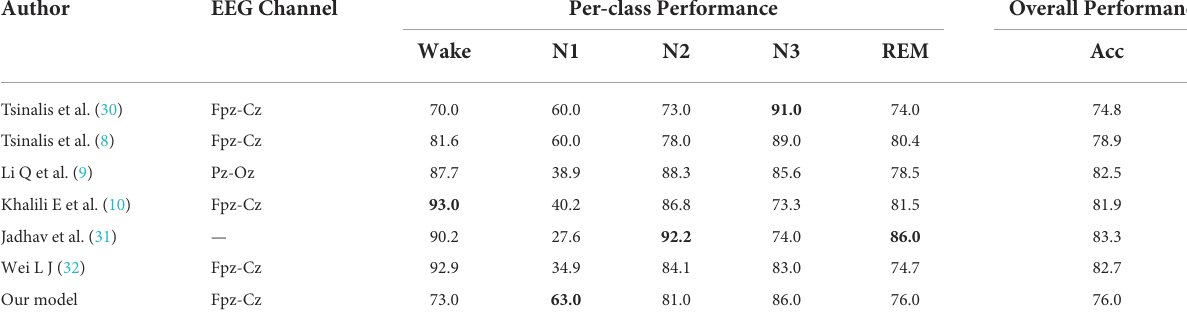
Table 6 misclassified a lot of Wake stage data to N1 stage), so resulted in lower Wake stage